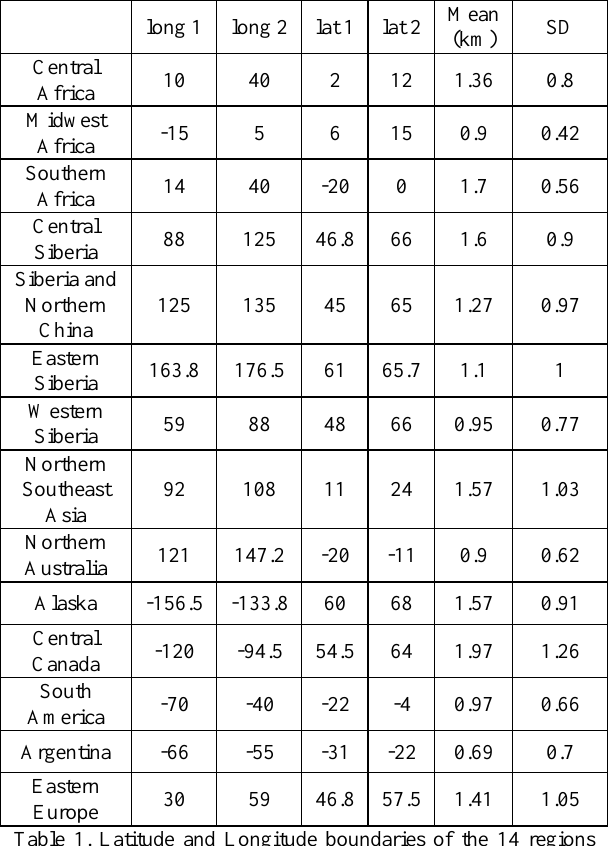
Table 1. Latitude and Longitude boundaries of the 14 regions studied in this